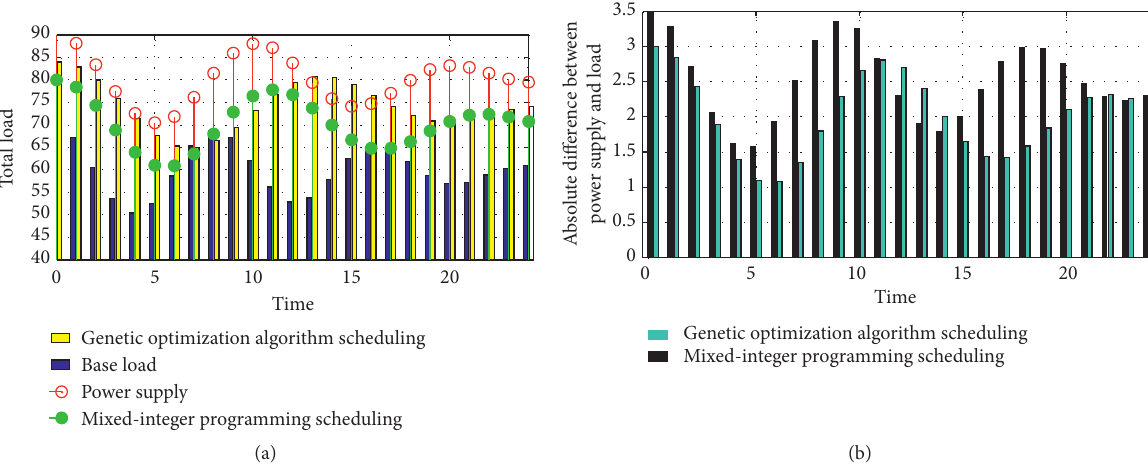
Figure 7: Comparison of total load and remaining unused power obtained by the two algorithms when N � 50. (a) Load power curve comparison. (b) Comparison of absolute difference between power supply and load.